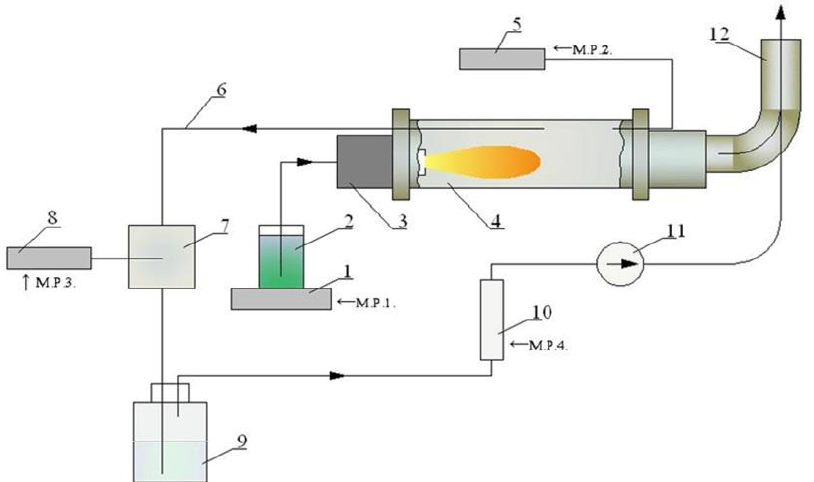
Figure 1. Experimental setup: (1) fuel consumption measuring device; (2) burette; (3) burner; (4) rotary kiln; (5) temperature indicator; (6) partial flue gas flow; (7) smoke analysis bottle; (8) smoke analyser; (9) flue gas washing bottle; (10) flue gas flow meter; (11) pump; (12) exhaust pipe; (M.P.1.); fuel consumption; (M.P.2.); flue gas temperature in the rotary kiln; (M.P.3.); flue gas analysis (O 2 , CO, CO 2 , NO, t); (M.P.4.); flue gas volumetric flow rate.